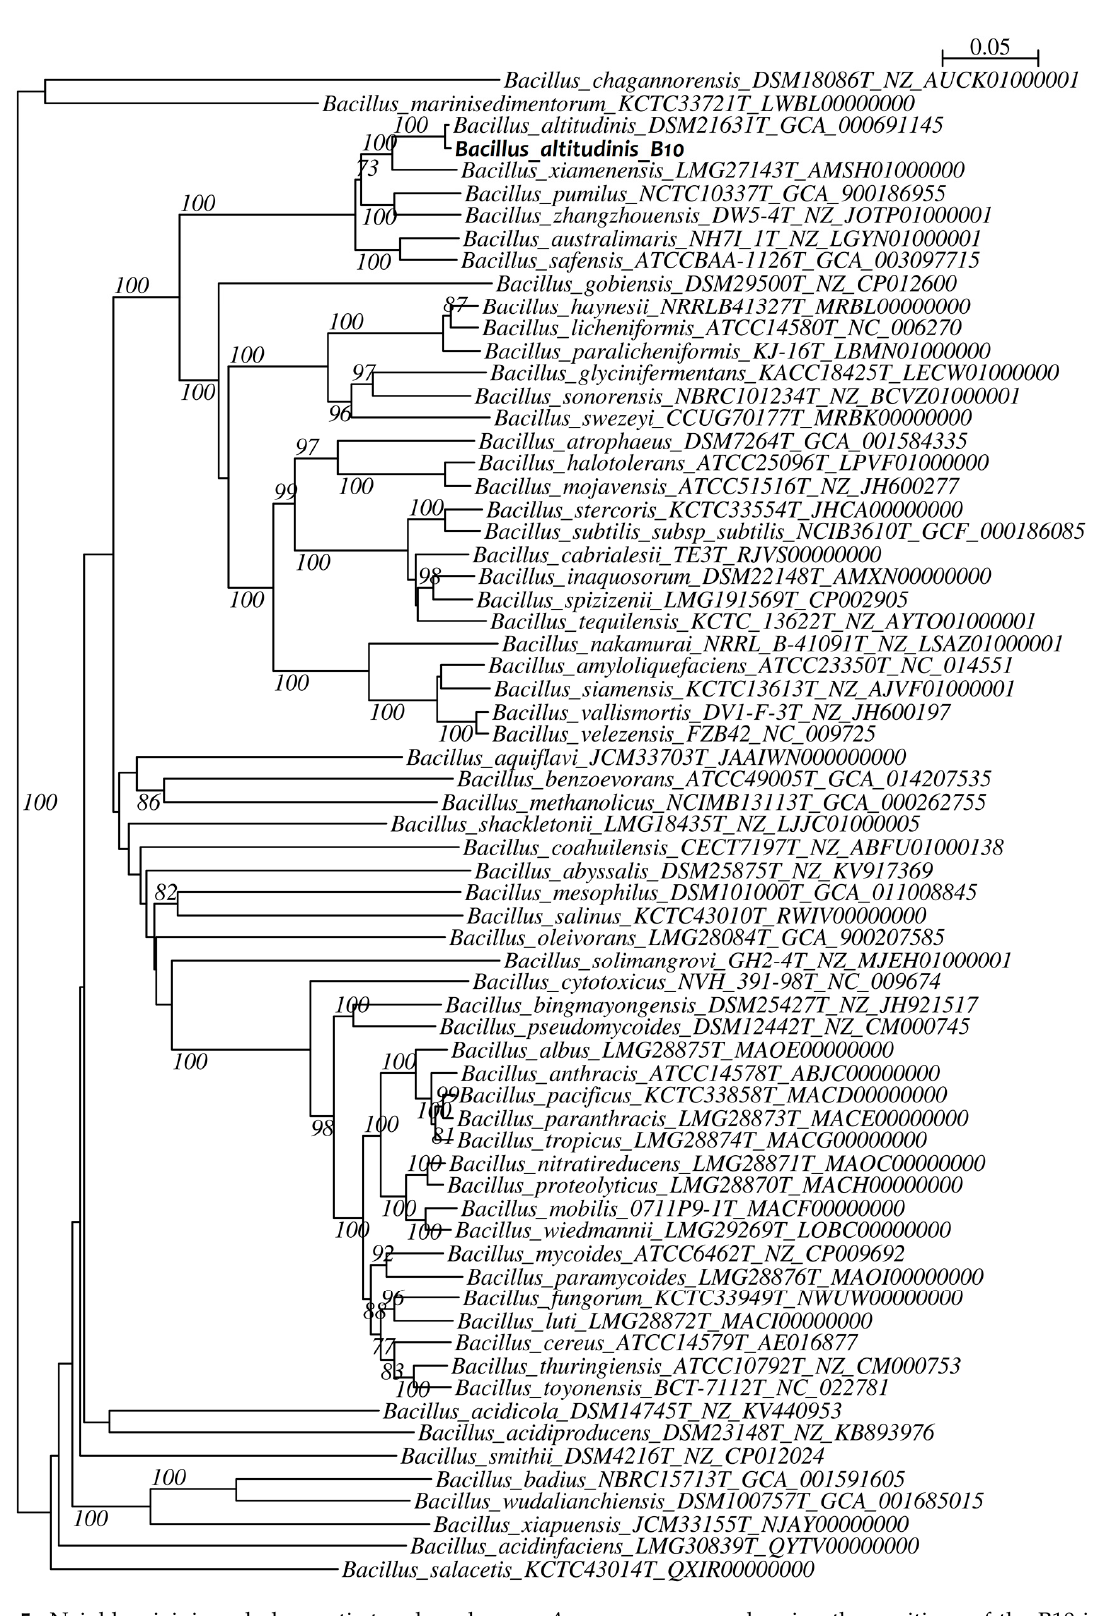
Figure 5. Neighbor-joining phylogenetic tree based on gyrA gene sequences showing the positions of the B10 isolate B. altitudinis and the type strains of the genus Bacillus. Bootstrap values >70 are shown above branches. Bar: 0.05 substitutions per nucleotide position. Sequence accession numbers are given following strain